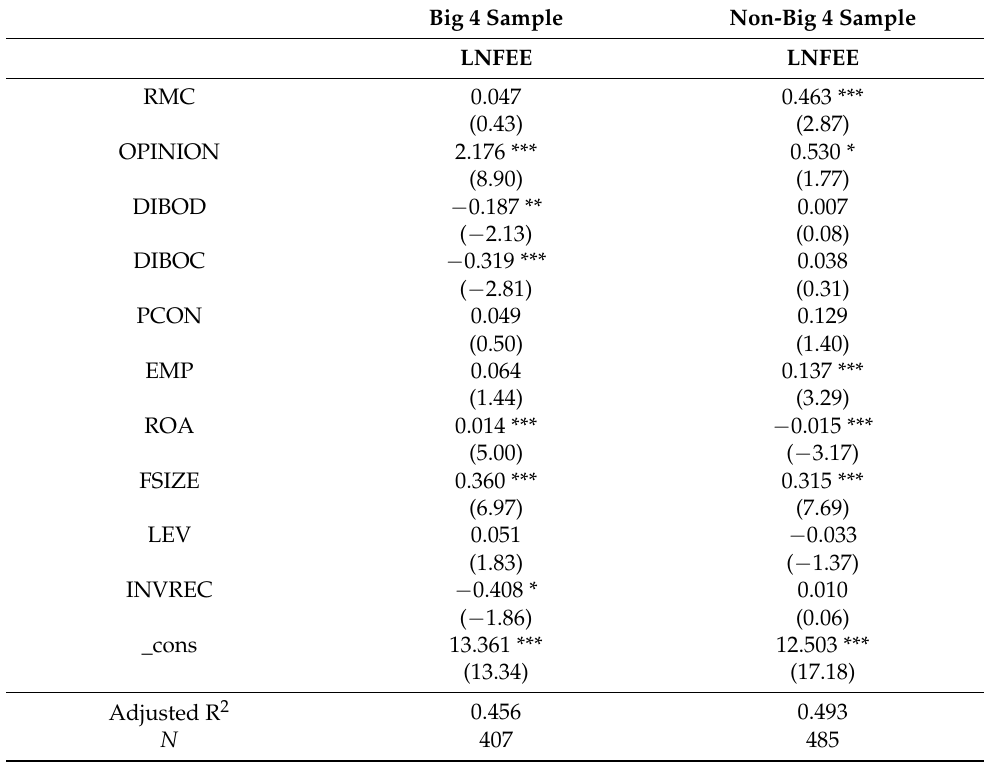
Table 7. Risk management committee and audit fee in split-sample